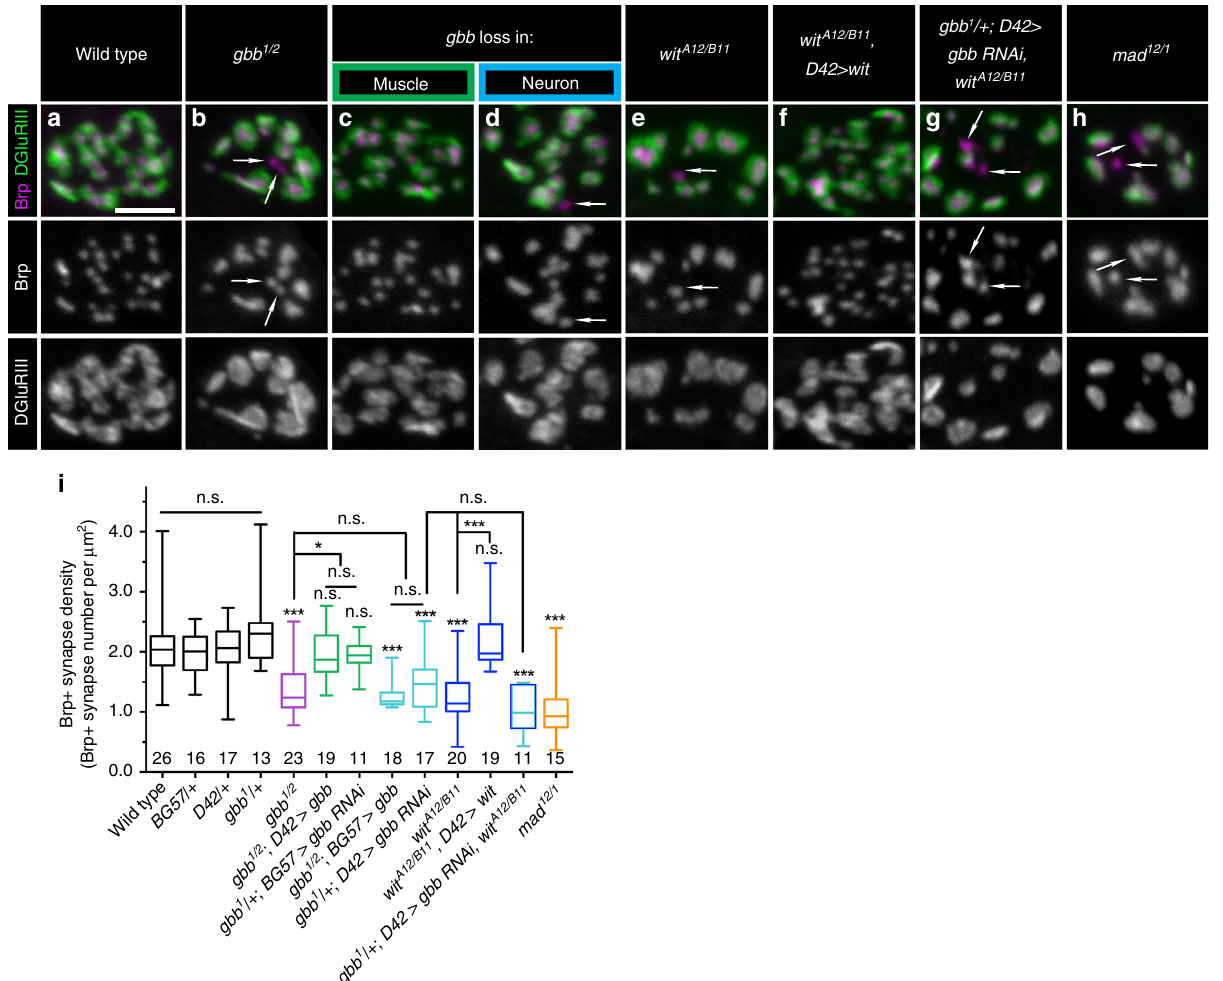
Fig. 1 A presynaptic and autocrine BMP pathway at the NMJ. a – h Representative z -projections of boutons of indicated genotypes labeled with Brp (magenta) and DGluRIII (green). gbb loss in muscle is gbb 1/2 ; D42>gbb , and gbb loss in neuron is gbb 1/2 ; BG57>gbb . Arrows denote unapposed Brp + puncta. Individual channels are shown in grayscale below or next to merged images for clarity throughout all fi gures. Scale bar: 2 µ m. i Quanti fi cation of Brp + synapse density (number of Brp + synapses per terminal bouton area in square microns). n is the number of boutons scored. Error bars are min and max data points, and the center line indicates the median. n.s. not signi fi cantly different. * p < 0.05; *** p < 0.001. Statistical test is a nonparametric Kruskal – Wallis one-way ANOVA on ranks followed by Dunn ’ s multiple comparison test. For all fi gures, source data are provided as a Source Data fi